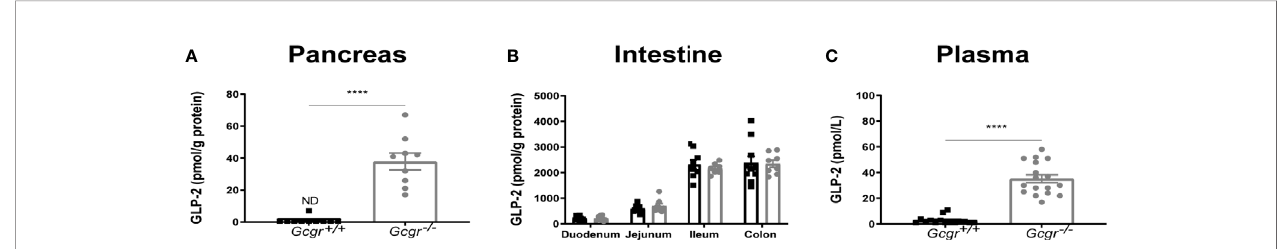
FIGURE 1 | Biochemical characterization of Gcgr − / − and Gcgr +/+ mice. Extracted GLP-2 (1-33) in (A) the pancreas and (B) intestine normalized to grams (g) protein determined by BCA assay. (C) Plasma levels of GLP-2 (1-33). Gcgr +/+ mice are shown in black and Gcgr − / − mice are shown in grey. Data were compared using a two-sided, unpaired students t-test and presented as means ± SEM. ****p value <0.0001, ND,